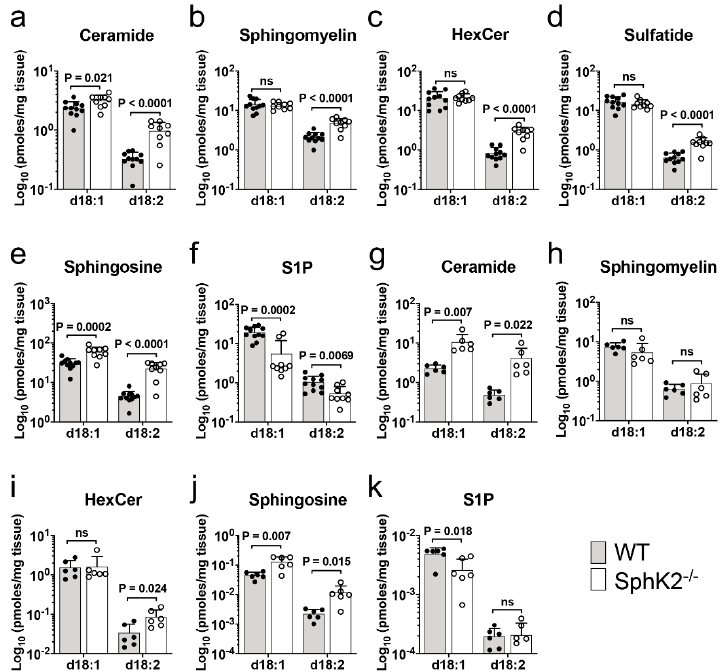
Figure 3. Increased sphingadienes in the hippocampus and liver of SphK2 − / − mice. ( a – f ) Total